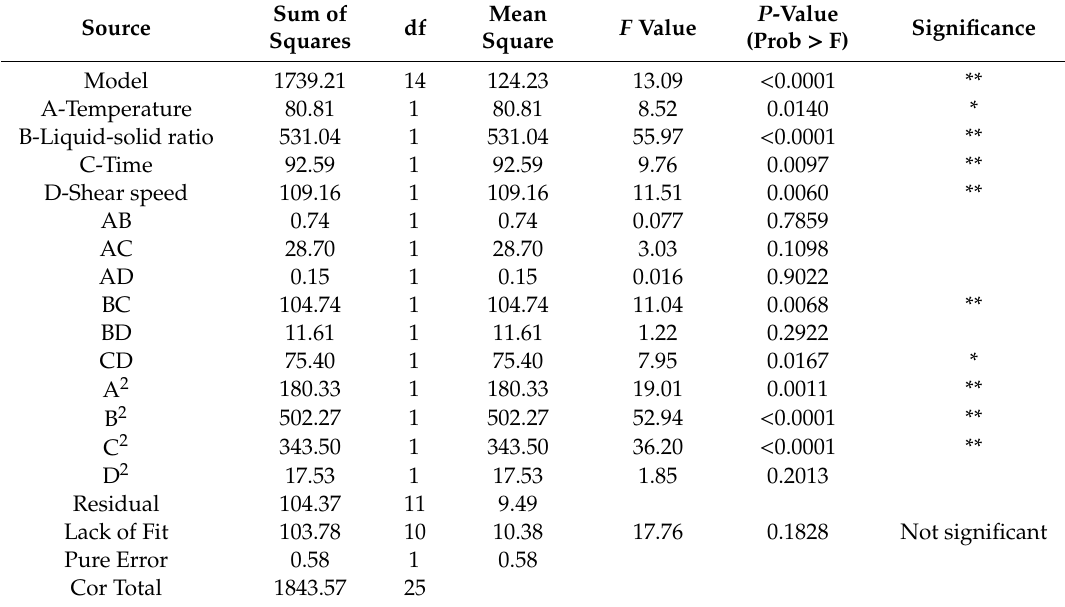
Table 2. Variance analysis of response surface quadratic model for the extraction of BS mucilage.